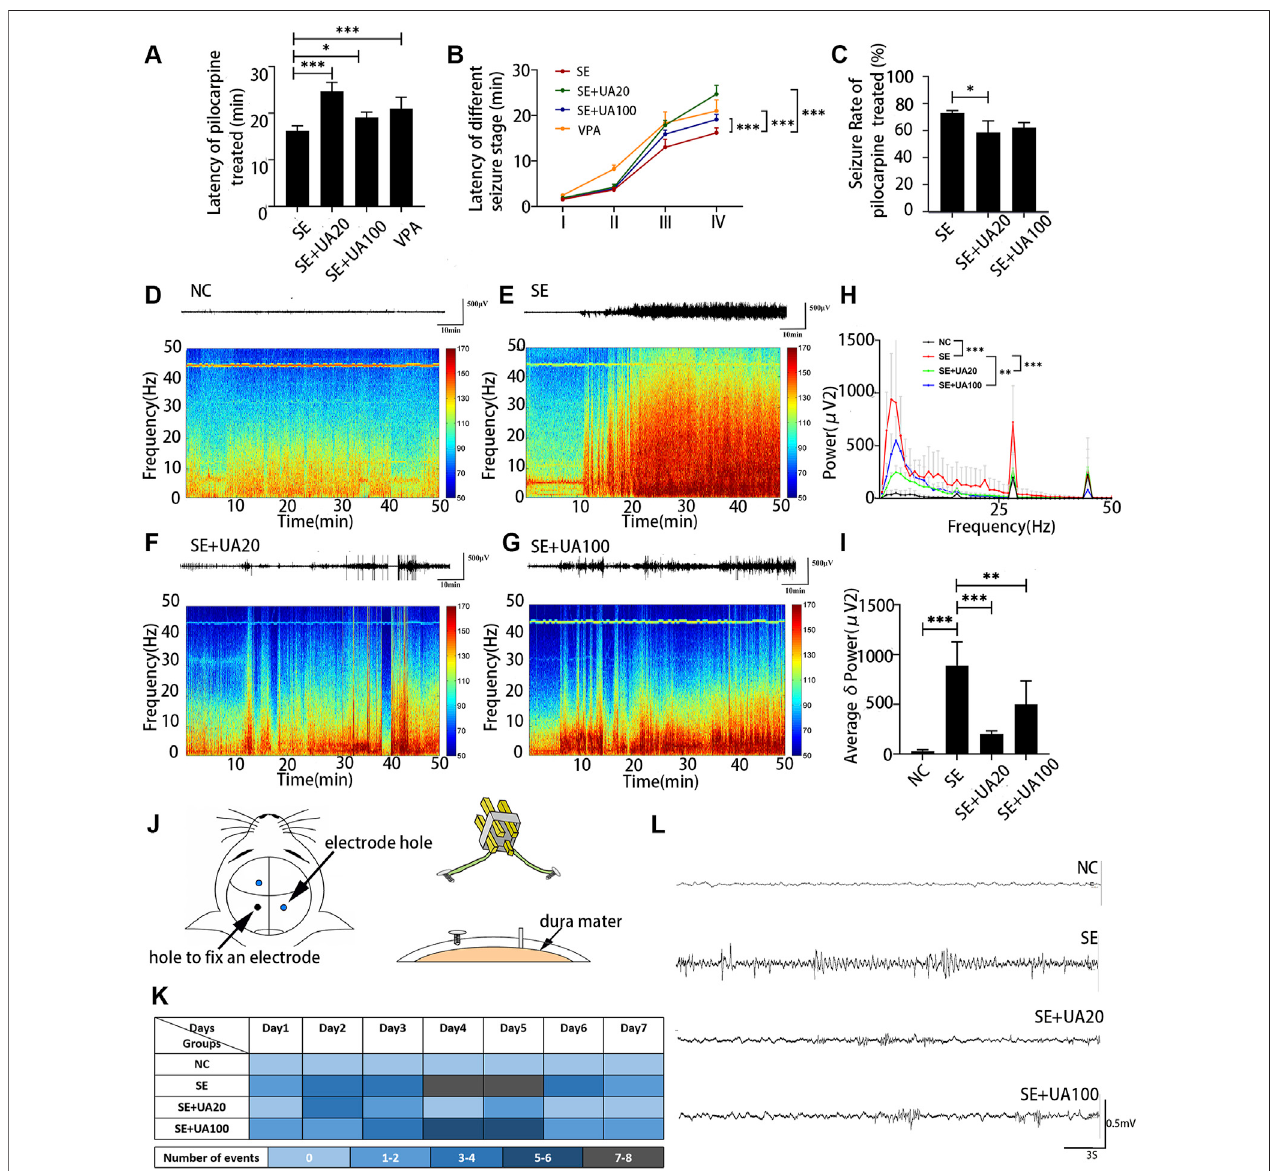
FIGURE 2 | UA reduced the seizure susceptibility and inhibited chronic epilepsy development of the model. (A) The latency of seizure occurrence induced by lithium-pilocarpine. (B) The latency of different seizure stage induced by lithium-pilocarpine. (C) Percentages of rats with developed SE induced by pilocarpine. (D – G) Representative traces of EEG activity and spectrograms of representative EEG recordings for 50 min. Bar: 500 μ v, 10 min. (H) FFT analysis of EEG recordings. (I) Comparisonoftheaverage δ (0.75 – 4 Hz)power. (J) Diagramofelectrodeimplantation. (K) Numberof “ EEGseizure ”